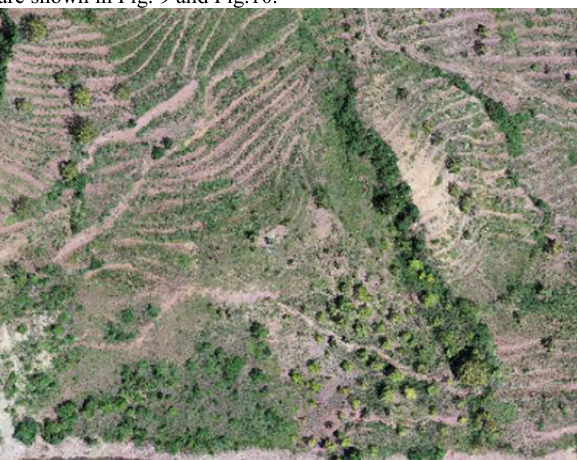
Figure 9 . Generalized orthophoto of deformed Regions of